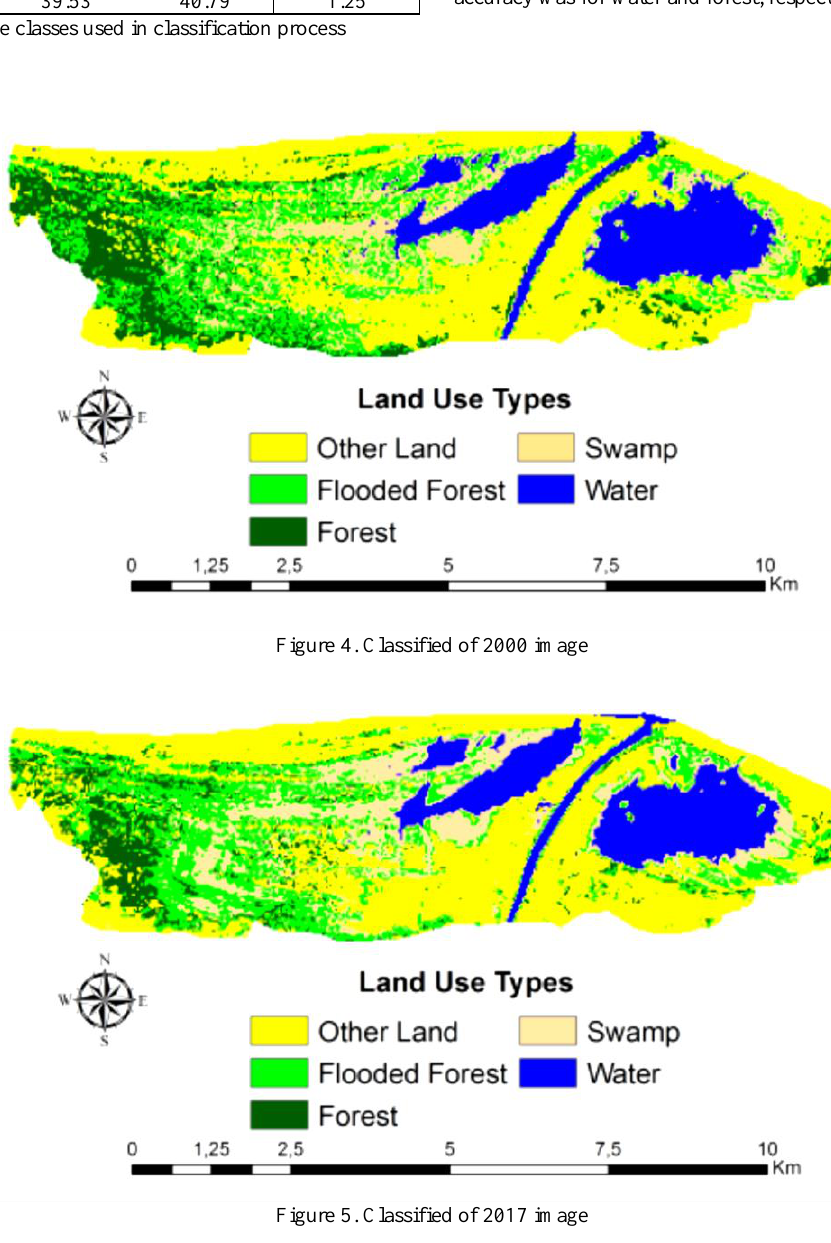
Figure 5. Classified of 2017